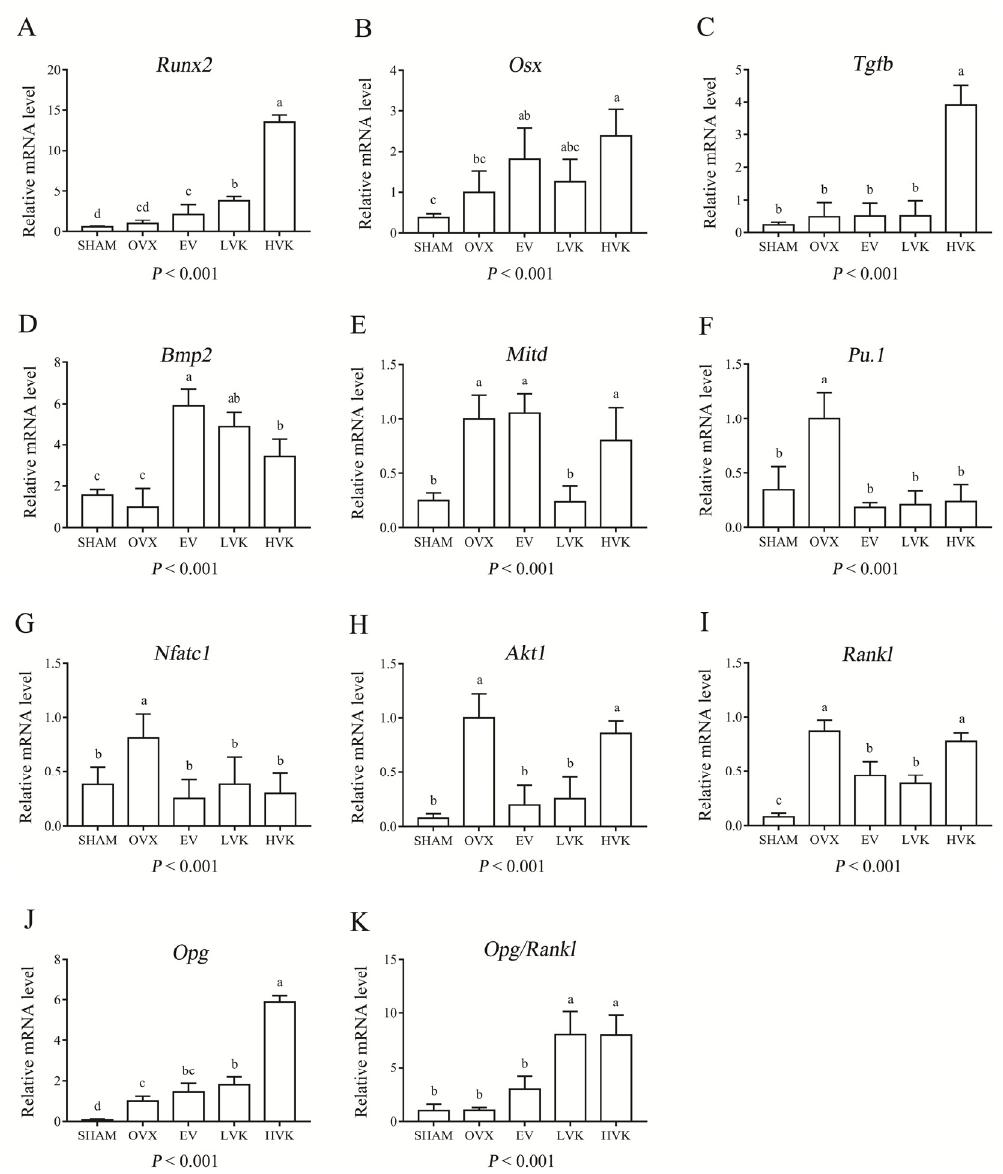
Figure 5. Genes related to bone formation and bone resorption in mice that were sham operated or ovariectomized and untreated or administered EV, LVK, or HVK for 12 weeks. The mRNA expression of Runx2 ( A ), Osx ( B ), Tgfb ( C ), Bmp2 ( D ), Mitd ( E ), Pu.1 ( F ), Nfatc1 ( G ), Akt1 ( H ), Rankl ( I ), Opg ( J ), Opg/Rankl ( K ). Values are mean ± SD, n = 5–6 per treatment. Labeled without a common letter means a significant difference, p < 0.05. EV, estradiol valerate; HVK; MK-4 40 mg/kg body weight group; LVK, MK-4 20 mg/kg body weight group; MK-4, menaquinone-4; OVX, ovariectomized group; SD, standard deviation.